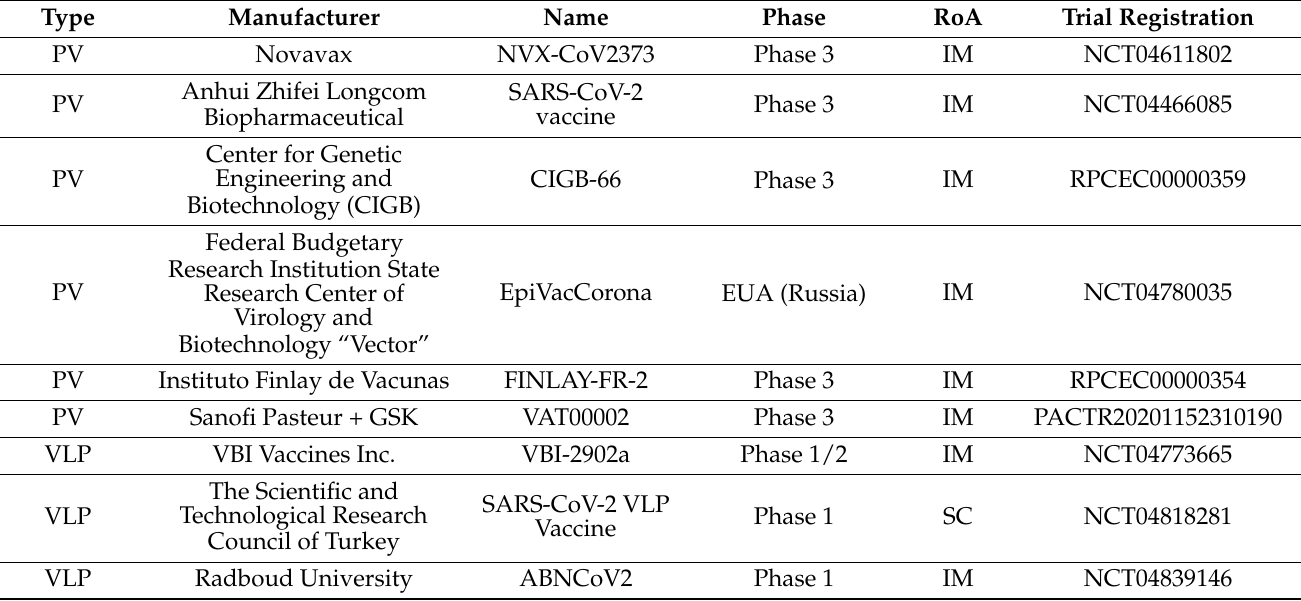
Table 1. Promising COVID-19 protein vaccine (PV) and virus-ike particle (VLP) candidates in clinical development.